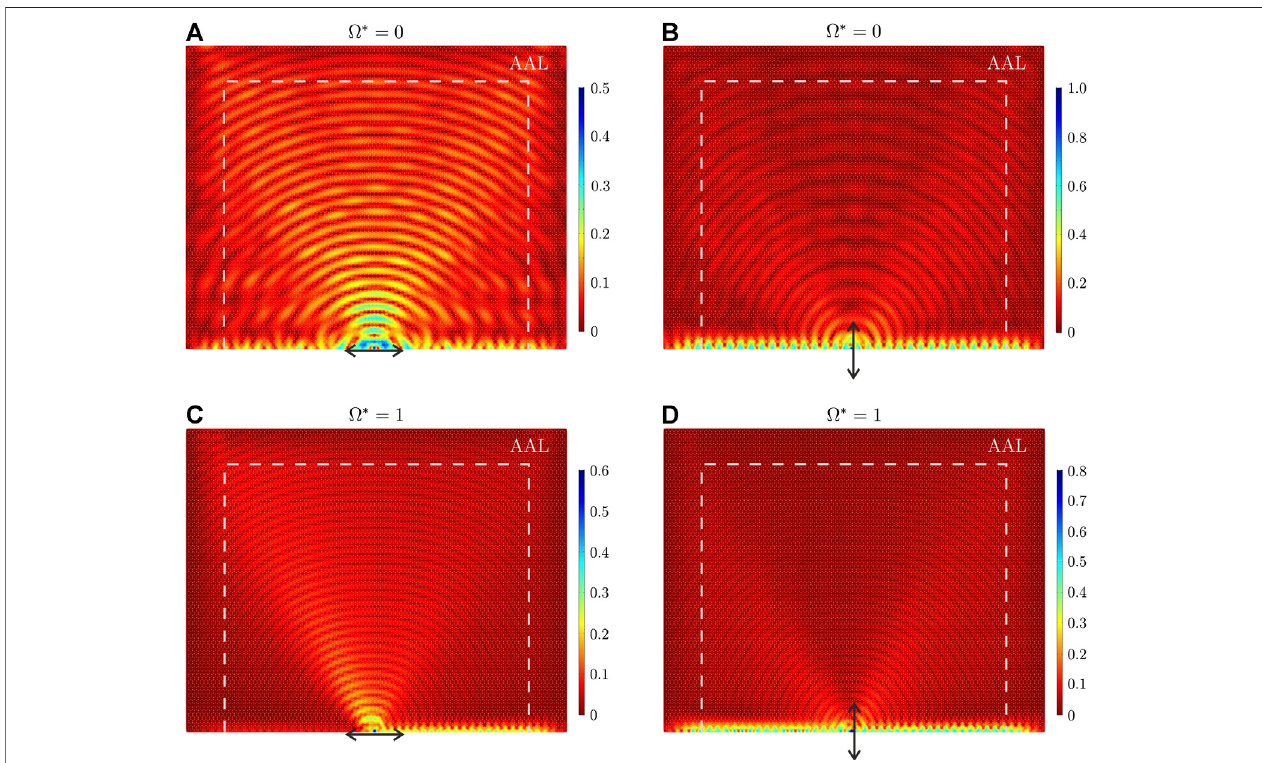
FIGURE 7 | Same as in Figure 6 , but obtained from numerical simulations performed in Comsol Multiphysics .